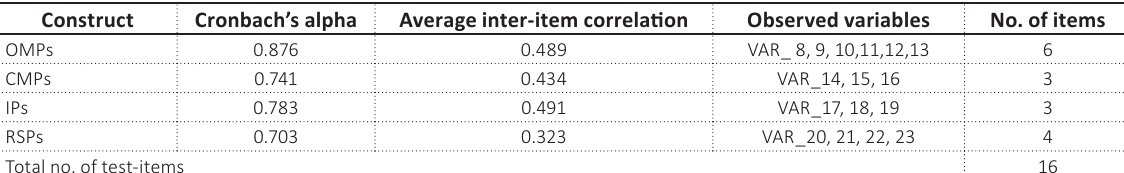
Table 1. Construct-wise reliability